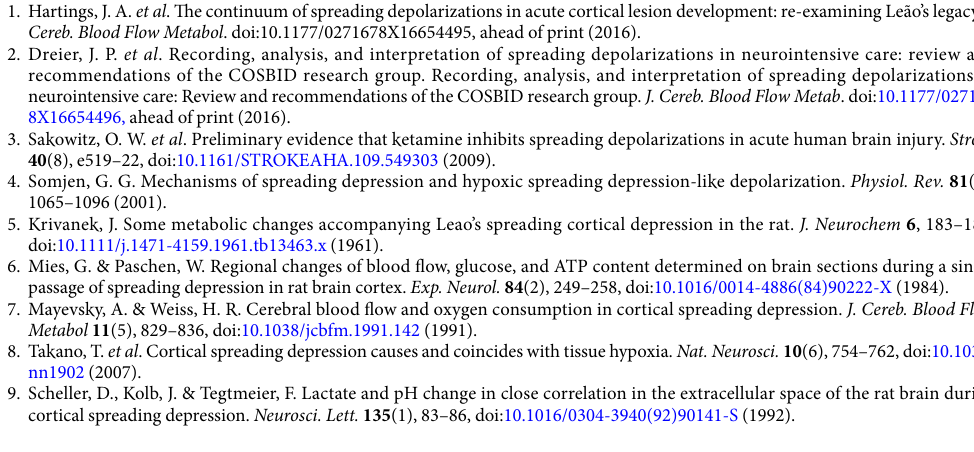
SDs were further subdivided into first SD (SD1), subsequent SDs during baseline, SDs under ischemia, and SDs during reperfusion. The impact of age was evaluated for both evoked and spontaneous SDs. Direct current poten- tial, pH and CBF variations with SD were processed and evaluated as reported earlier 22 . Briefly, the amplitudes of depolarization, acidosis and hyperemia with SD were defined at the maximum deflection relative to baseline. The maximum rates of depolarization, acidosis and hyperemia were calculated as the respective slopes taken for a linear segment of the signal, fit to the inflexion point (i.e. most rapid change). The duration of the events was measured at half amplitude. Local changes in NR fluorescence intensity and CBF with time were extracted by placing regions of interest (ROIs) of 19 × 19 pixel size (~70 × 70 μ m) at selected sites devoid of any blood vessels visible in the images. CBF recordings obtained by LDF or LASCA were expressed relative to baseline by using the average CBF value of the first 240 s of baseline (100%) and the recorded biological zero obtained after terminating each experiment (0%) as reference points. Data are given as mean ± stdev. The software SPSS (IBM SPSS Statistics for Windows, Version 22.0, IBM Corp.) was used for statistical analysis. Distinct statistical methods are provided in detail in each Figure legend.